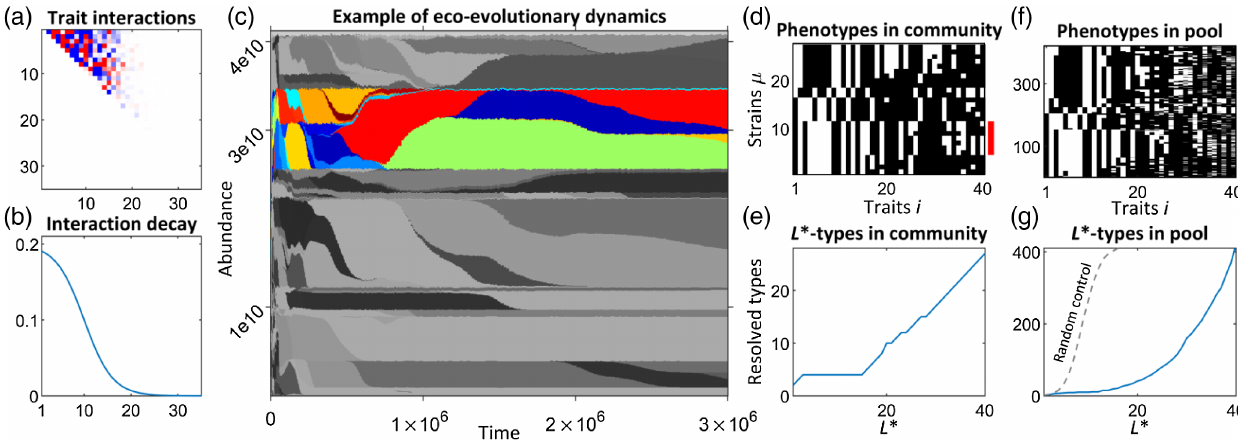
FIG. 2. A simple model of trait interactions leads to hierarchically structured ecosystems. (a),(b) In our model, the traits carried by a given phenotype interact with each other to determine its “ maintenance cost ” (see the text). The matrix of pairwise trait interactions J ij is drawn randomly and is the same for all phenotypes, encoding the “ biochemical constraints ” ; (a) shows an example ( J ij is triangular with one element per trait pair i ≠ j ). We assume an interaction structure such that a few traits interact strongly while others interact weaker and weaker (b). (c) An example of ecoevolutionary dynamics generated in our model. Shading corresponds to different phenotypes. Although new strains continue to emerge and die out throughout the period shown, they can be grouped into several coarse-grained types of approximately stable abundance (one is highlighted in color). (d) The phenotypes present at the end point of the trajectory shown in (c). Each of 27 phenotypes is a row of length L ∞ ¼ 40 (white pixels are carried traits). The seven highlighted strains are identical in traits 1 – 24. We say that they belong to the same “ L (cid:3) -type, ” for level of coarse-graining L (cid:3) ¼ 24 . (e) The number of L (cid:3) -types in the community in (d), shown as a function of L (cid:3) . At a coarse-grained level, the community appears to consist of only four types [one of these is highlighted in (c) using color]; resolving finer substructure requires L (cid:3) > 15 . (f),(g) The same as (d) and (e) for a broader set of strains, 50 similar environments. The hierarchical structure is maintained (if the trait matrix were randomized, the number pooled over M env ¼ of L (cid:3) -types would grow exponentially; see the dashed line). Here, we ask: In what sense, if any, could the phenotypic details beyond L (cid:3) ≈ 20 – 25 be coarse-grained away in this